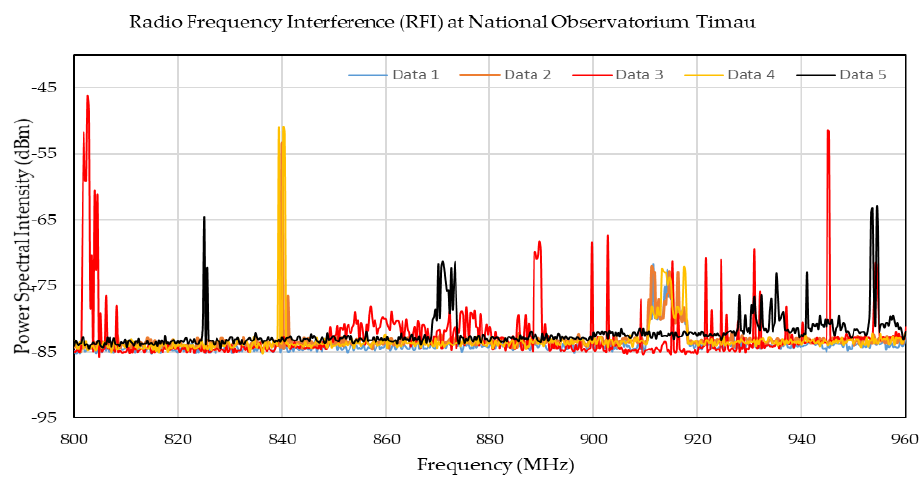
Figure 6. Results of radio frequency survey at low frequencies between 800 and 960 MHz.